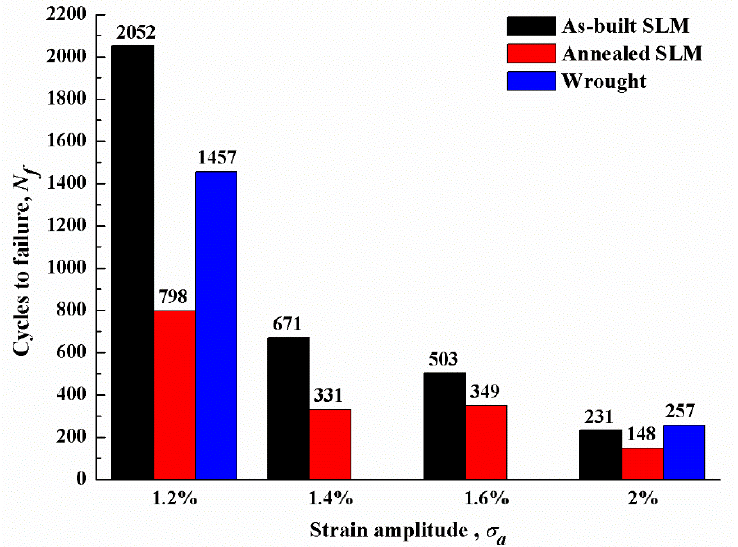
Figure 7. Number of cycles to failure ( N f ) for low cycle fatigue (LCF) for the samples of Ti – 6Al – 4V.